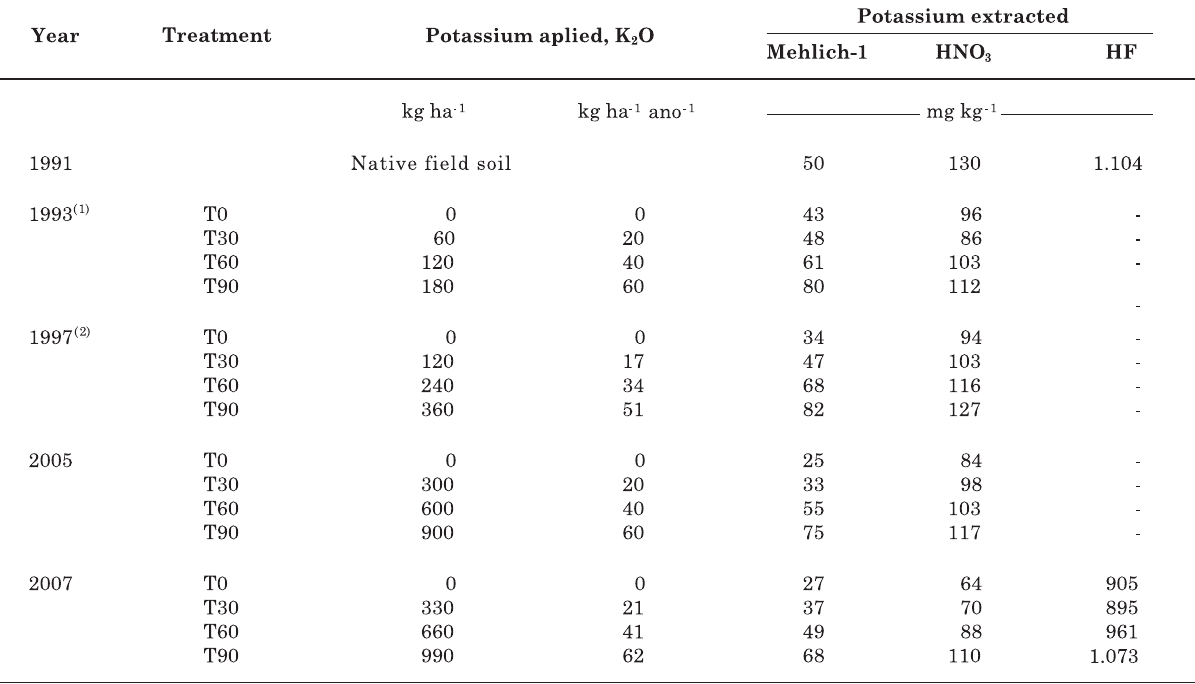
Table 1. Potassium content of the main plot extracted by Mehlich-1, 1 mol L -1 HNO up of the experiment in 1993, 1997 and